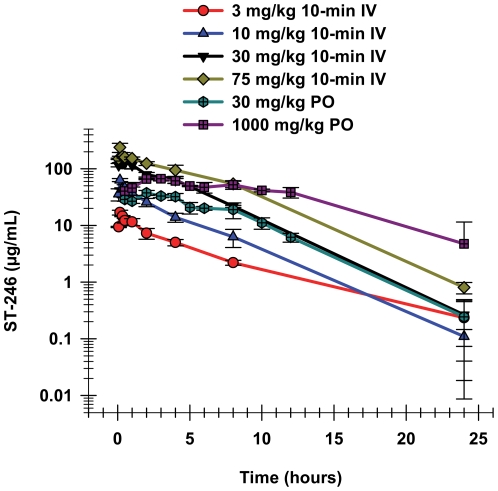
Plasma concentration time curves for oral and IV administration of ST-246 in mice.The means and standard deviations of the plasma concentrations over time are shown after oral administration of ST-246 to female BALB/c mice at doses of 30 (chartreuse hexagons) and 1000 mg/kg (purple squares). The means and standard deviations of the plasma concentrations over time after 10 minute IV infusions to female CD-1 mice at 3 (red circles), 10 (blue triangles), 30 (black triangles), and 75 mg/kg (green diamonds). Each time point is the mean value from three individual mice.